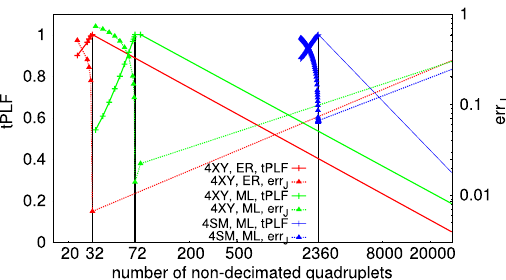
Figure 4. Tilted pseudolikelihood tPLF (normalized to its maximum) and reconstruction error for different models. Concave curves are tPLF, convex curves are err J . Three apart models on different random graphs are considered. Red (left) curves: 4 XY model on sparse Erdos-Renyi graph with N = 32, N q = 32, M = 65000, at T = 1.2 ( .  T (32) 1 39 ). Green (mid) curves: 4 XY model on sparse Mode-Locked graph with N = 32, N q = 72, c M = 65000, at T = 1.8 ( .  T (32) 0 72 ). Blue (right) curves: 4SM model on dense Mode-Locked graph with c N = 32, N q = 2360, M = 65000, at T = 6.2 ( .  T (32) 0 91 c